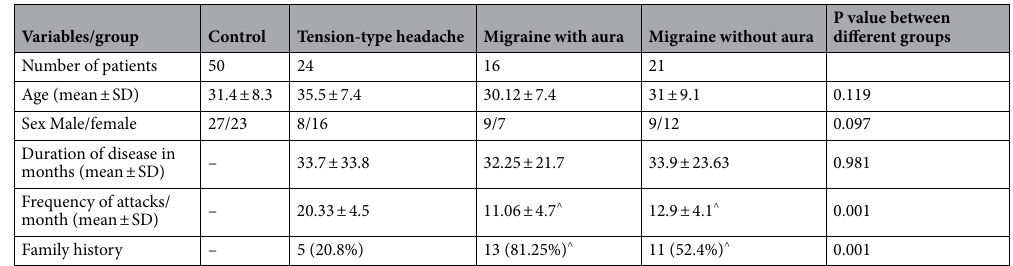
Table 1. Demographic and clinical data of studied groups. P value is significant < 0.05, between groups, ^ Migraine group versus tension headache group.